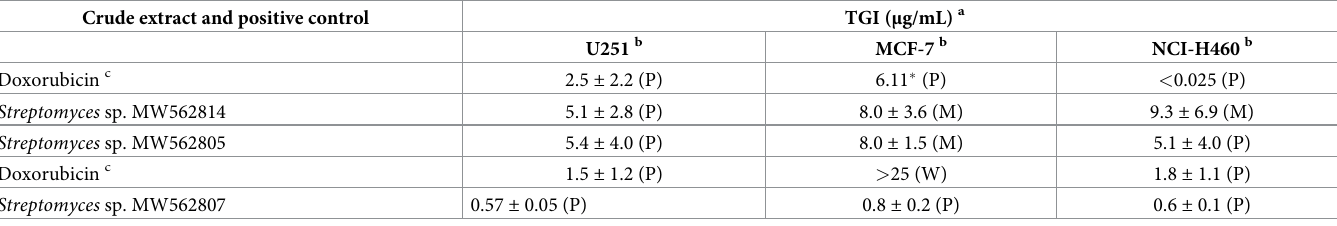
Table 4. Antiproliferative activity of three Streptomyces extracts against human tumor cell lines. Crude extract and positive